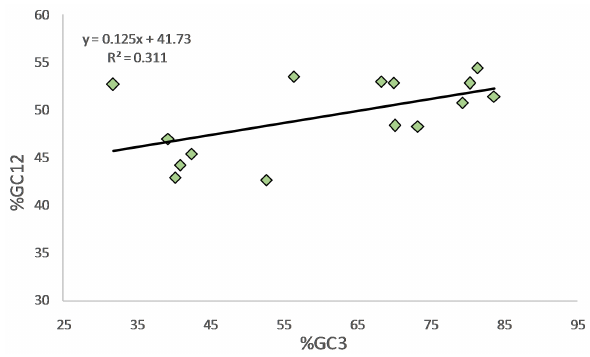
Fig. 7. Regression analysis between %GC3 and %GC12. The plot indi- cates the dominance of selectional force (87.42%) over mutational pressure